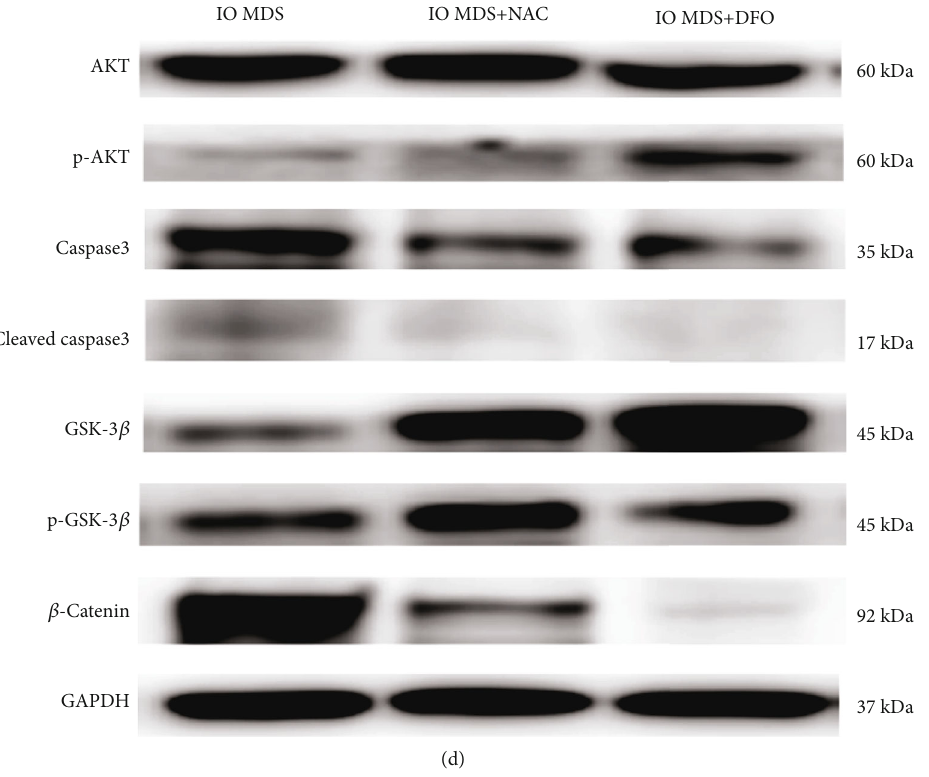
Figure 3: The e ff ects of antioxidant or iron chelation treatments on IO MDS MSCs. (a) The levels of ROS in IO MDS MSCs were signi fi cantly decreased after the treatments with NAC or DFO. (b) The apoptosis of IO MDS MSCs was signi fi cantly decreased after the treatments with NAC or DFO. (c) The gene expressions of caspase3 and β -catenin in IO MDS MSCs were signi fi cantly downregulated after the treatments with NAC or DFO. (d) The protein of p-AKT in IO MDS MSCs was upregulated after the treatments with NAC or DFO, while caspase3 was downregulated. The protein of β -catenin in IO MDS MSCs was downregulated after the treatments with NAC or DFO, while GSK-3 β was upregulated. Compared with the IO MDS group: & indicates p < 0 : 05 ; && indicates p < 0 : 01